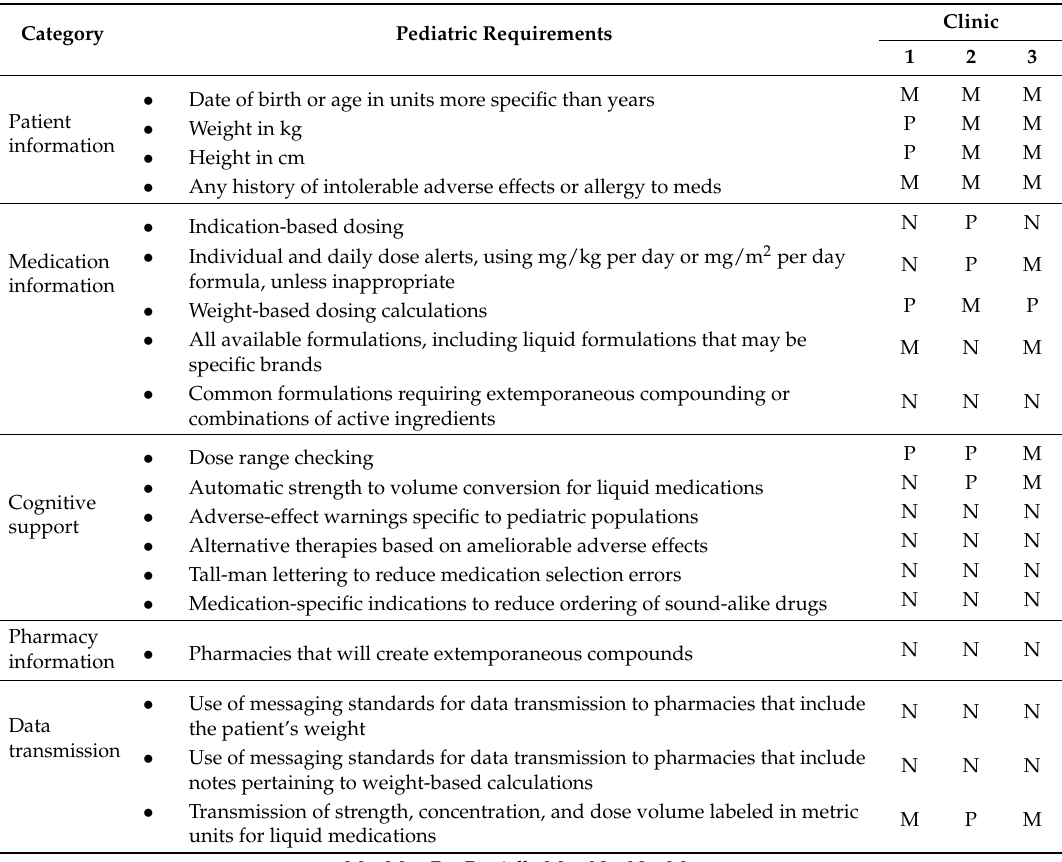
Table 1. American Academy of Pediatrics (AAP) requirements for safe and effective electronic prescribing